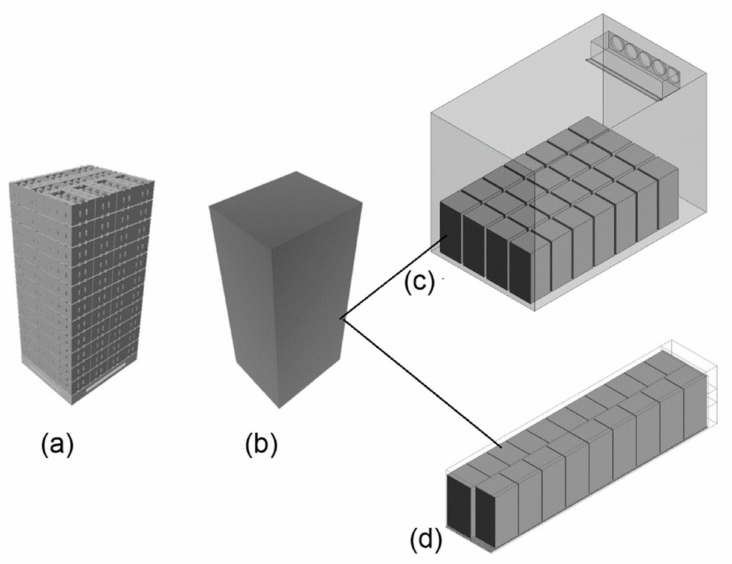
Figure 9. The porous medium modeling approach. Stacked and palletized fruit ( a ), porous medium model of a pallet ( b ), porous replica of a pallet placed in a cool storeroom ( c ), and in a refrigerated transport container ( d